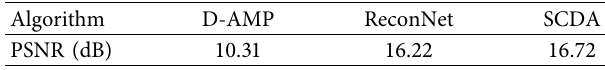
Table 3: Reconstruction accuracy comparison results of D-AMP, ReconNet, and SCDA algorithms (the measurement rate is 0.05).